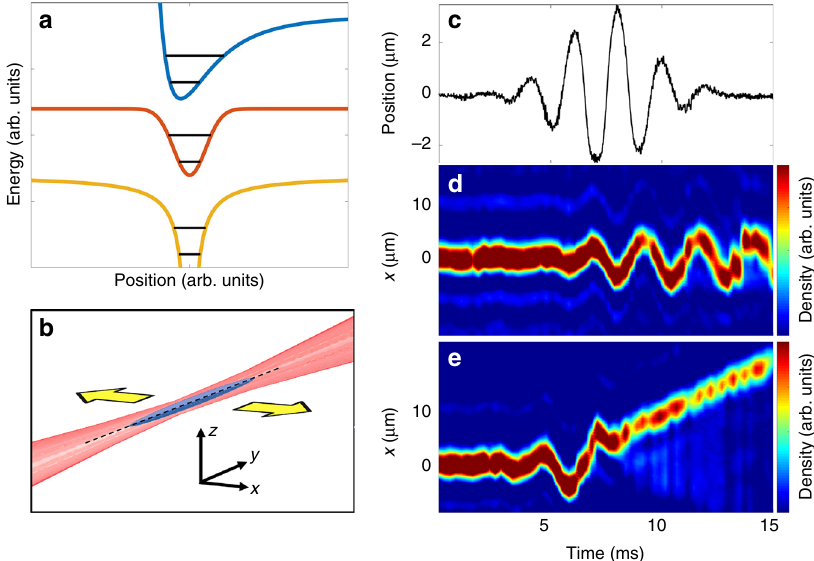
Fig. 1 Quantum simulation of ultrafast dynamics. a Schematic bound states of Lennard – Jones, Gaussian, and 1/ r potentials (offset for clarity). b Diagram of optical trap (red), which is shaken in the ^ x direction to generate inertial forces on the condensate (blue). c Measured trap position α ( t ) during a pulse. d Response to a weak pulse. Colormap shows density distribution after time of fl ight as a function of time. Pulse carrier frequency is 450 Hz, pulse envelope width is 3.76 ms, pulse amplitude is 0.6 μ m, and carrier-envelope phase is 0, as de fi ned in Eq. (2). e Response to a stronger pulse. Unbinding occurs near 8 ms, after which the atoms propagate with constant velocity. Pulse amplitude is 2.4 μ m. All other pulse parameters are identical to those in